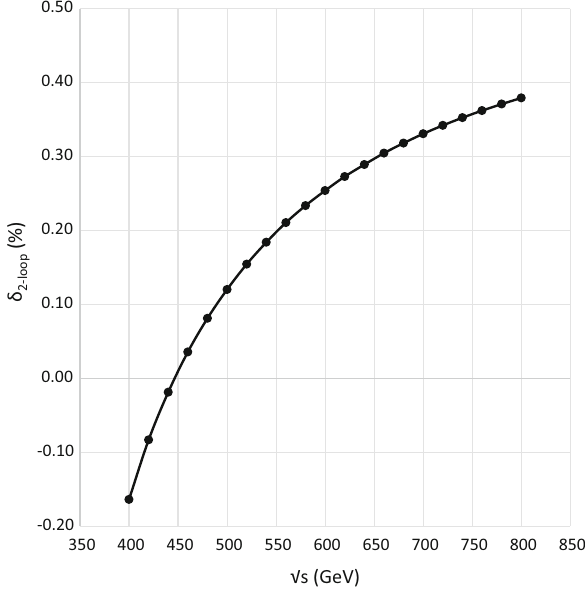
Fig. 3 Angular distributions of a top quark. A solid line (with triangle points), dotted line (with rectangle points) and dashed line (with circle points) show the tree, tree with ISR and NLO with ISR cross-sections